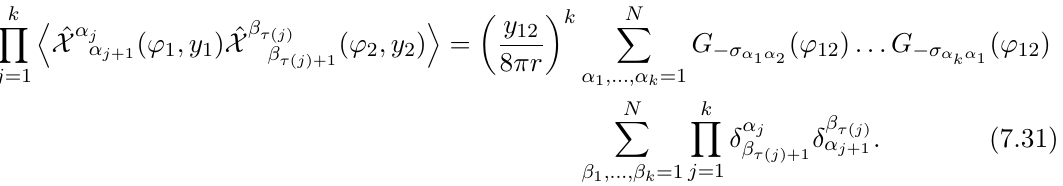
. To k indices and the β indices j τ ( j )+1